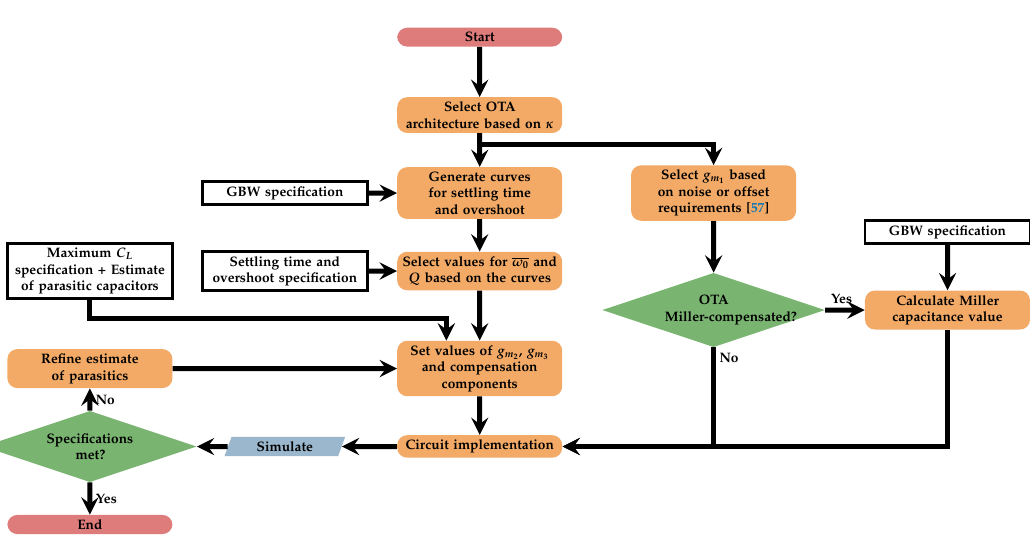
Figure 7. Flowchart for the design procedure discussed in this work.